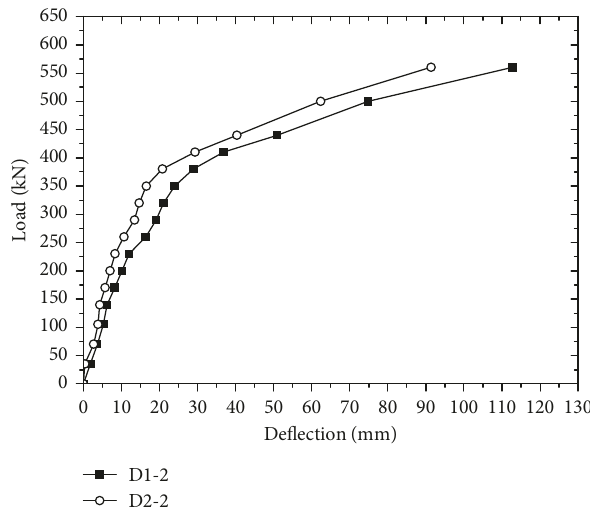
Figure 11: Load-deflection curve at the midspan section of the hollow